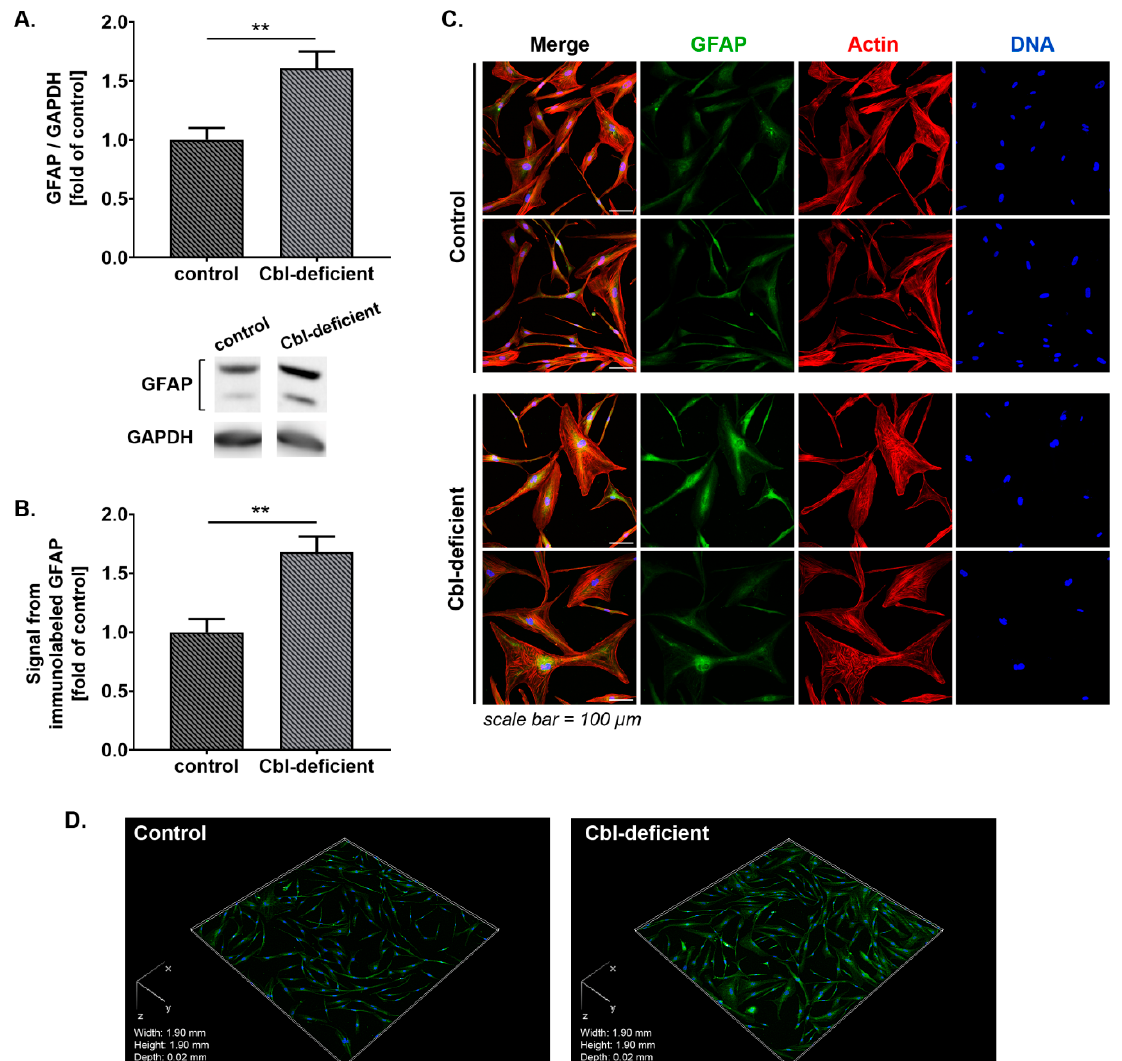
Figure 1. Cobalamin deficiency leads to an increased expression of glial fibrillary acidic protein (GFAP) in human astrocytes. ( A ) Western blot analysis (bar graph and representative blot images) of GFAP level in control and cobalamin-deficient NHA. ( B ) The total fluorescence intensity of immunolabeled GFAP normalized to cell number was quantified from z-stacked confocal images (21 stacks / image) using Nikon NIS Elements AR software. These quantifications were expressed relative to control. ( C ) Representative microscopic images of GFAP expression in cultured astrocytes; scale bar shows 100 µ m. ( D ) Example 3D reconstruction of the confocal z-stack images of cultured astrocytes immunolabeled against GFAP. Data in bar graphs correspond to mean ± S.D. values from three independent experiments in at least duplicate; statistically significant di ff erences are designated as ** p < 0.01 for comparisons between groups using unpaired t-test.